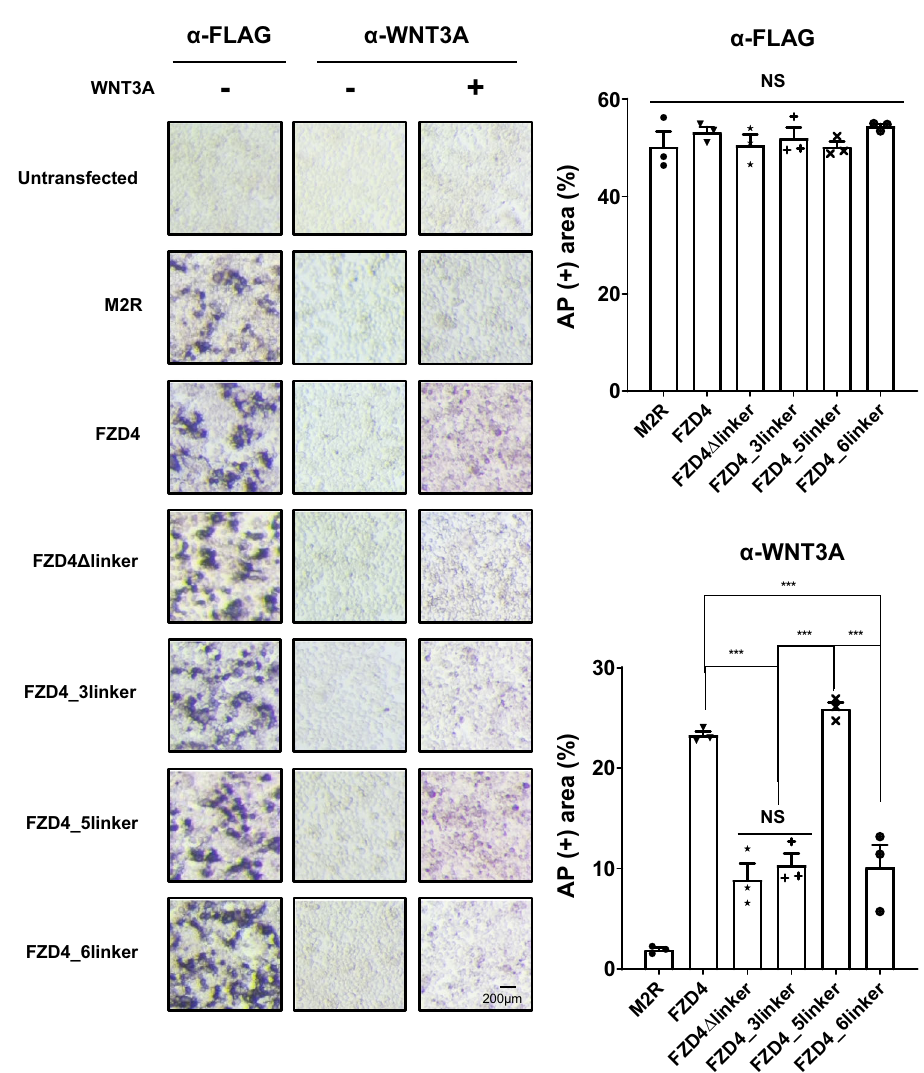
Fig. 3 FZD linker domain regulates WNT3A binding to FZD on cell surface. AP-stained images of dFZD1-10 − / − cells transfected with target receptors, with or without L3a treatment. Surface-expressed receptors and receptor-bound WNT3A were detected by AP-conjugated anti-FLAG and anti-WNT3A antibodies, respectively. Bound antibodies were subsequently visualized using NBT/BCIP substrates (Scale bar: 200 µ m). The AP-stained area was quantitatively analyzed using ImageJ and displayed as a bar graph. The error bar indicates the SD (standard deviation) of three replicates. Statistical comparisons were performed using one-way ANOVA followed by the Tukey ’ s test. ‘ NS ’ represents ‘ not signi fi cant ’ and ‘ *** ’ represents P